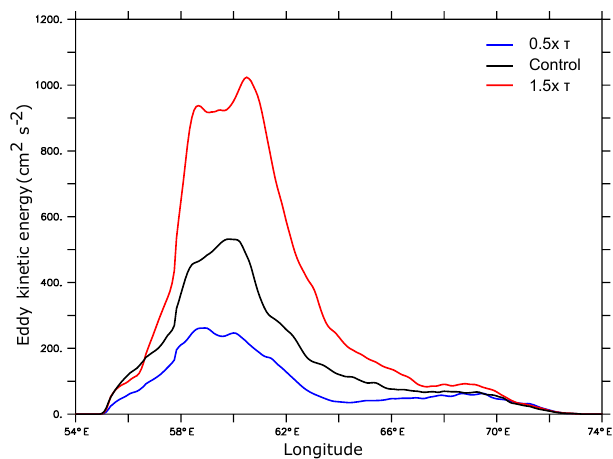
Figure 10. Eddy kinetic energy as a function monsoon wind in- tensity. Latitudinally averaged eddy kinetic energy (in cm 2 s − 2 ) be- tween 17 and 20 ◦ N as simulated under monsoon wind perturbations is